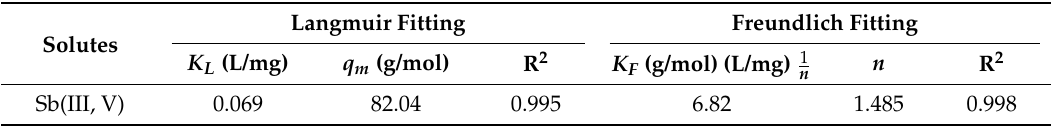
Table 3. Parameters of the Langmuir and Freundlich adsorption models for Sb species on FC precipitates in the quaternary